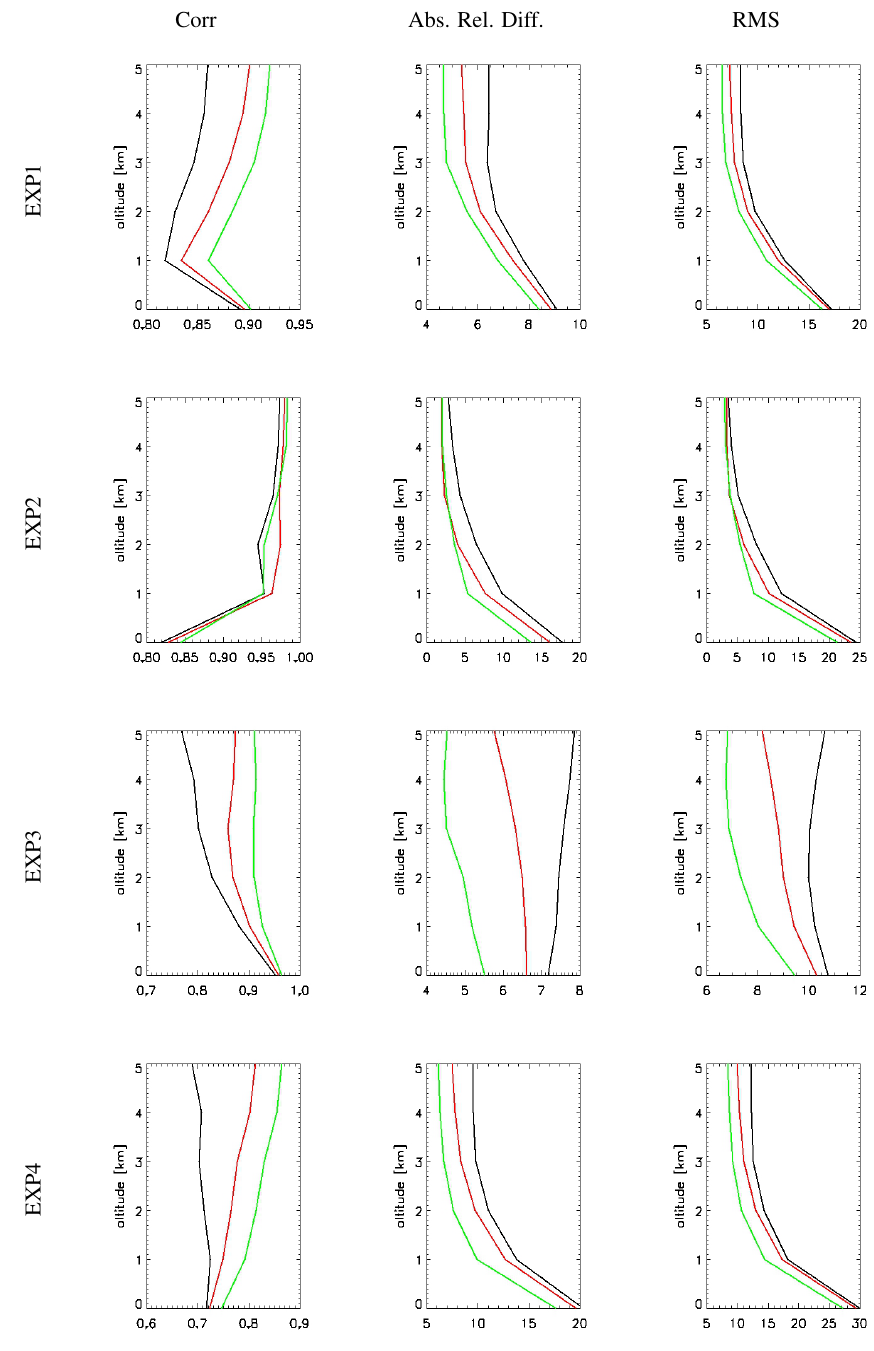
Fig. 14. Same as Fig. 13 but for CO.